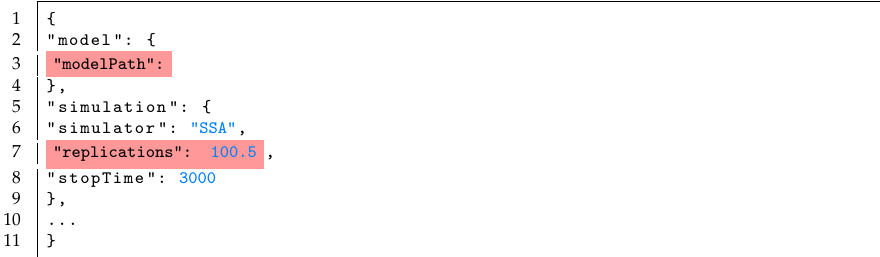
Listing 2. Simulation experiment filled according to the JSON meta model defined in Listing 1. Validation errors in the specification are marked